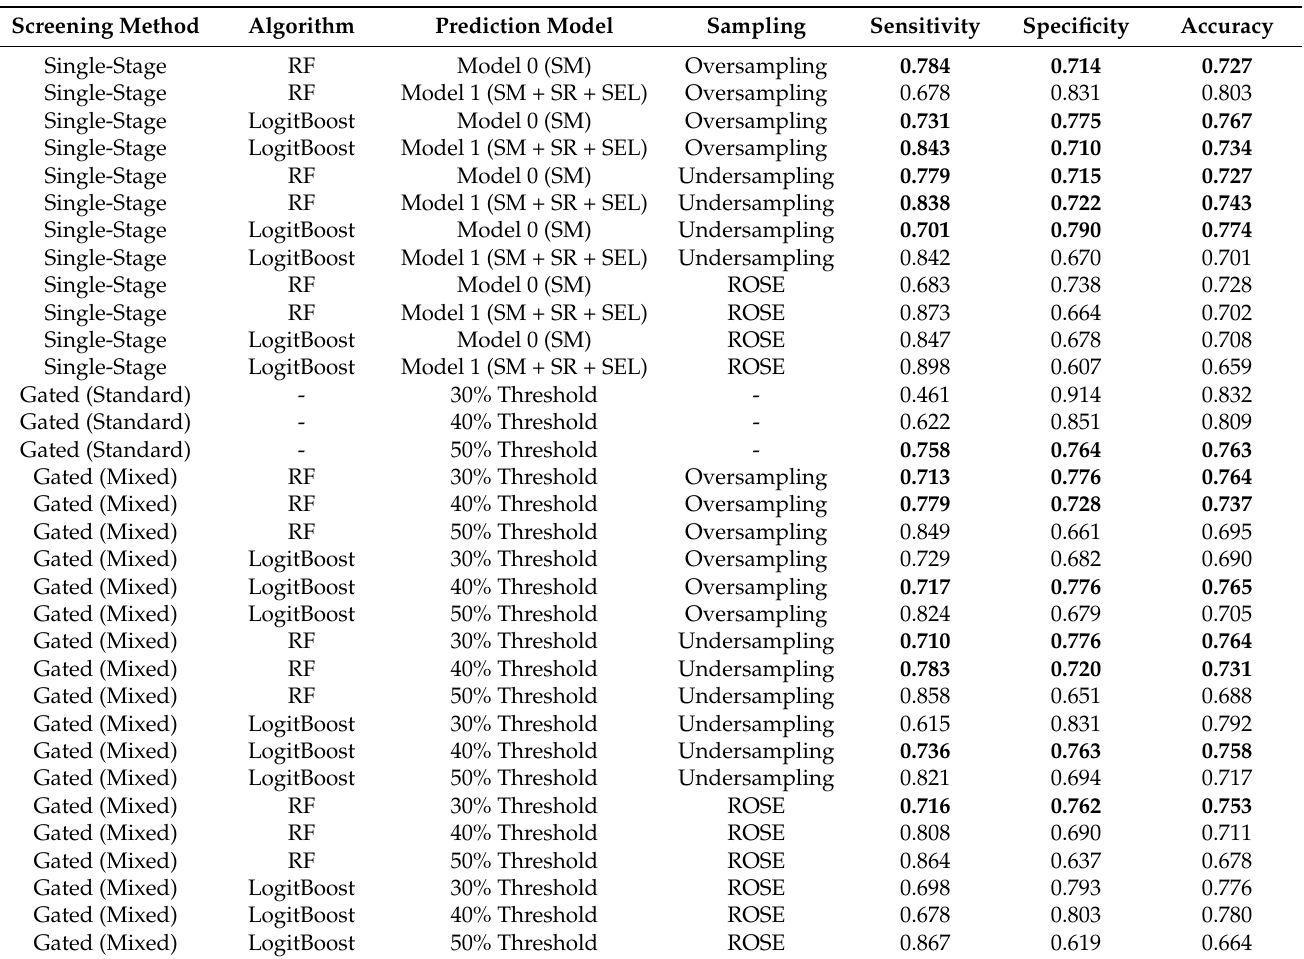
Table 2. Sensitivity, Specificity, and Accuracy Results for the 2017–2018 School